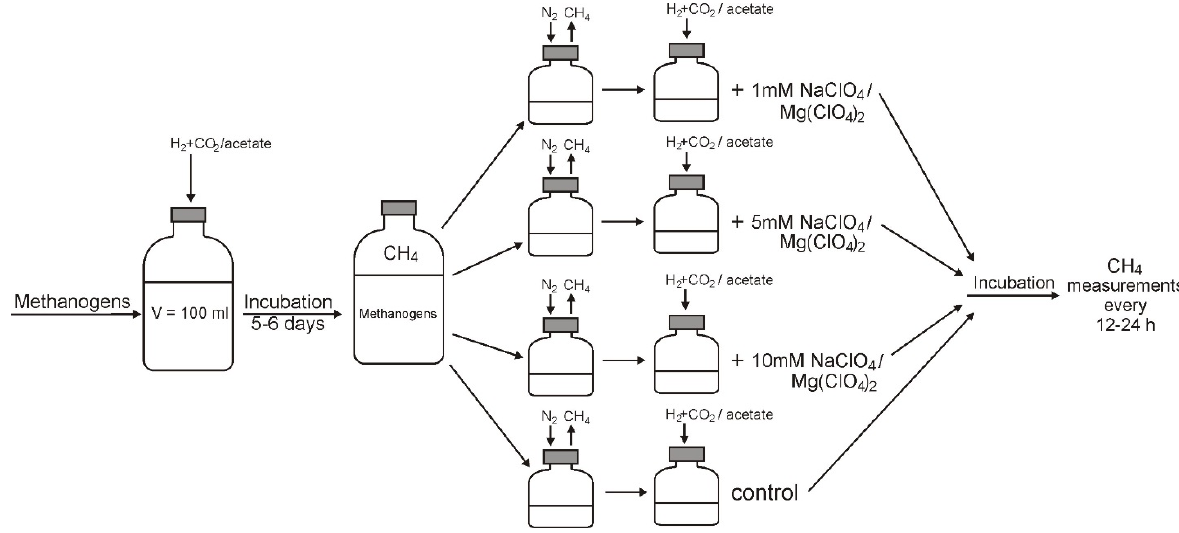
Figure 1. Scheme of the experiment for determining the inhibitory concentrations of